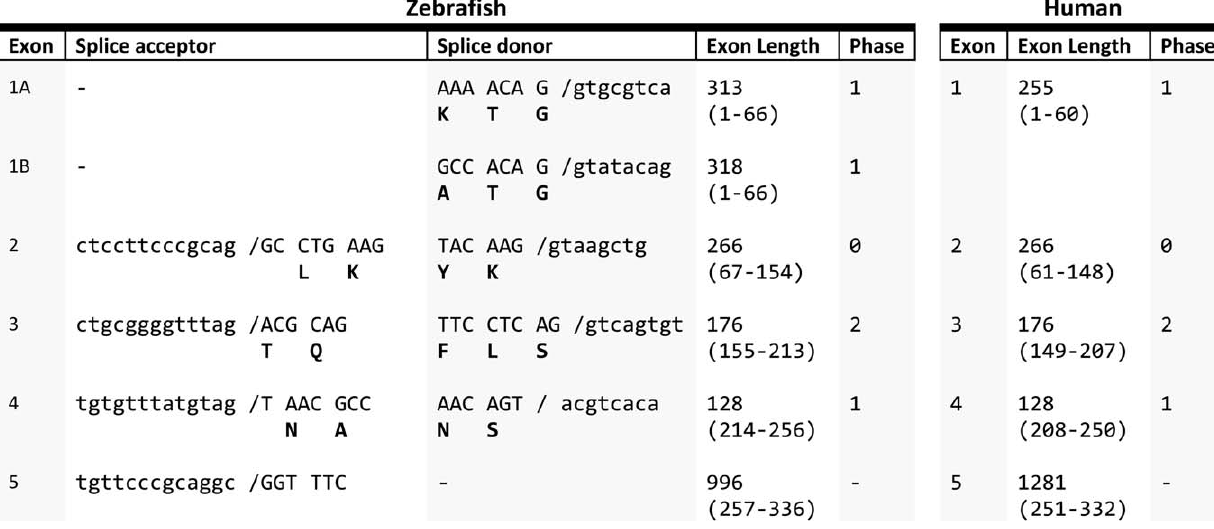
Figure 5. Genomic organization of zebrafish tor1 compared with human TOR1A. The splice acceptor and donor sequences for each intron/ exon boundary of the zebrafish tor1 gene are shown, alongside the length of each exon and the phase of each splice boundary. The exon length and phase of human TOR1A are shown for comparison.